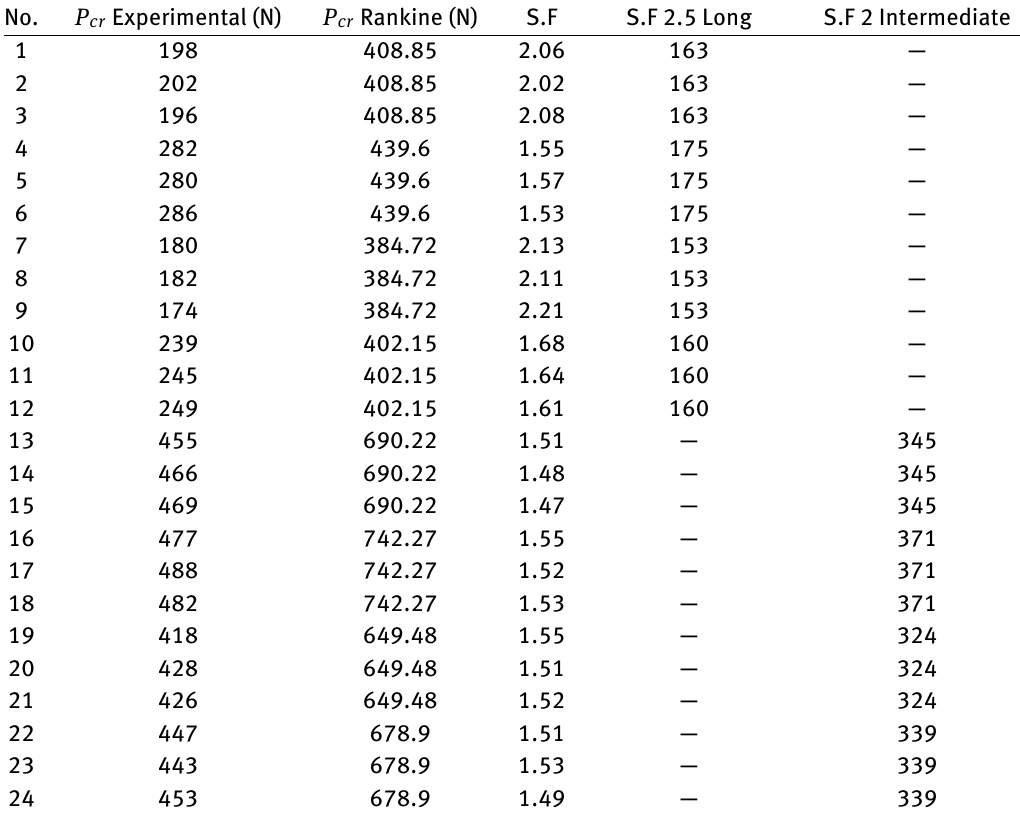
Table 8: Comparison between the Rankine-Gordon formula results and the experimental results